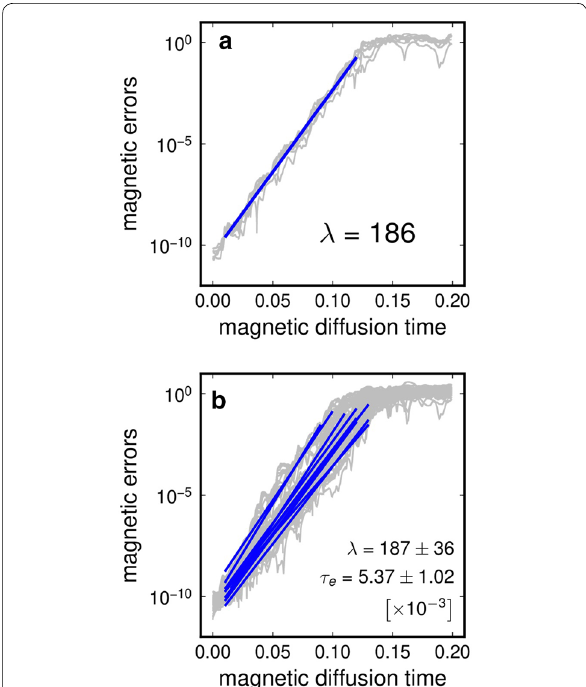
Fig. 3 Error growth rates of the numerical geodynamo model. The top panel a shows an example of estimation of error growth rate using least-squares linear regression, where the gray lines denote magnetic errors, (cid:31) y l (Eq. 19), for the spherical harmonic degree from 1 to 8, and the blue line is the result of the linear regression. The bottom panel b shows superimposed ten results of estimation of error growth rates, where the average error growth rate turns out to be 187 with 95 percent uncertainty (2 σ ) of 36. See text for details of the